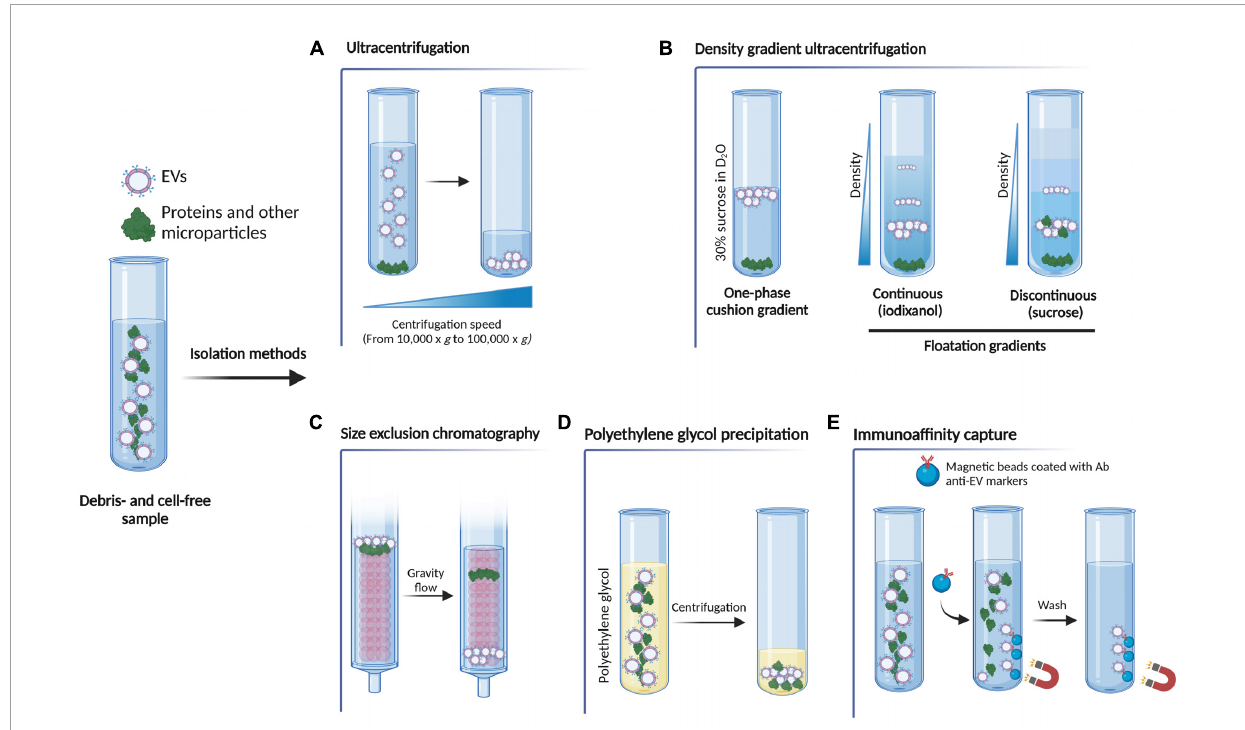
FIGURE2 Schematic representation of the most common EV isolation methods. (A) Ultracentrifugation exploits high centrifugal forces to separate the EVs from the rest of the sample. (B) Density gradient ultracentrifugation separates EVs according to their size, mass and density. The sample can be placed on top of a 30% sucrose in D 2 O solution (one-phase cushion gradients) and, upon ultracentrifugation, denser molecules sediment on the bottom of the tube, whilst the EV fraction stays on top according to its density. In floatation gradients, the sample is placed either at the bottom or at the top of the continuous (iodixanol) or discontinuous (sucrose) gradient and the molecules float up or sediment down to the point where their density is the same as the density of the solution. (C) Size exclusion chromatography uses a porous polymer that separates molecules based on size. Proteins are retained by the column by entering the pores of the polymer, so they elute later than EVs. By contrast, EVs, having a bigger size than the pores of the polymer, pass through the column quicker and so elute first. (D) Polyethylene glycol (PEG) precipitation exploits an aqueous PEG solution to wrap EVs, producing particle aggregates that can be then pelletted via centrifugation. (E) Immunoaffinity capture isolation uses the binding between an EV membrane protein marker and its specific antibody to remove other non-specific components. Figure created with